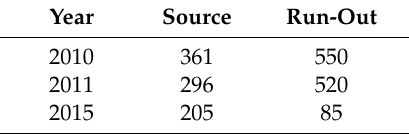
Table 6. Numbers of extracted source and run-out samples of later records.